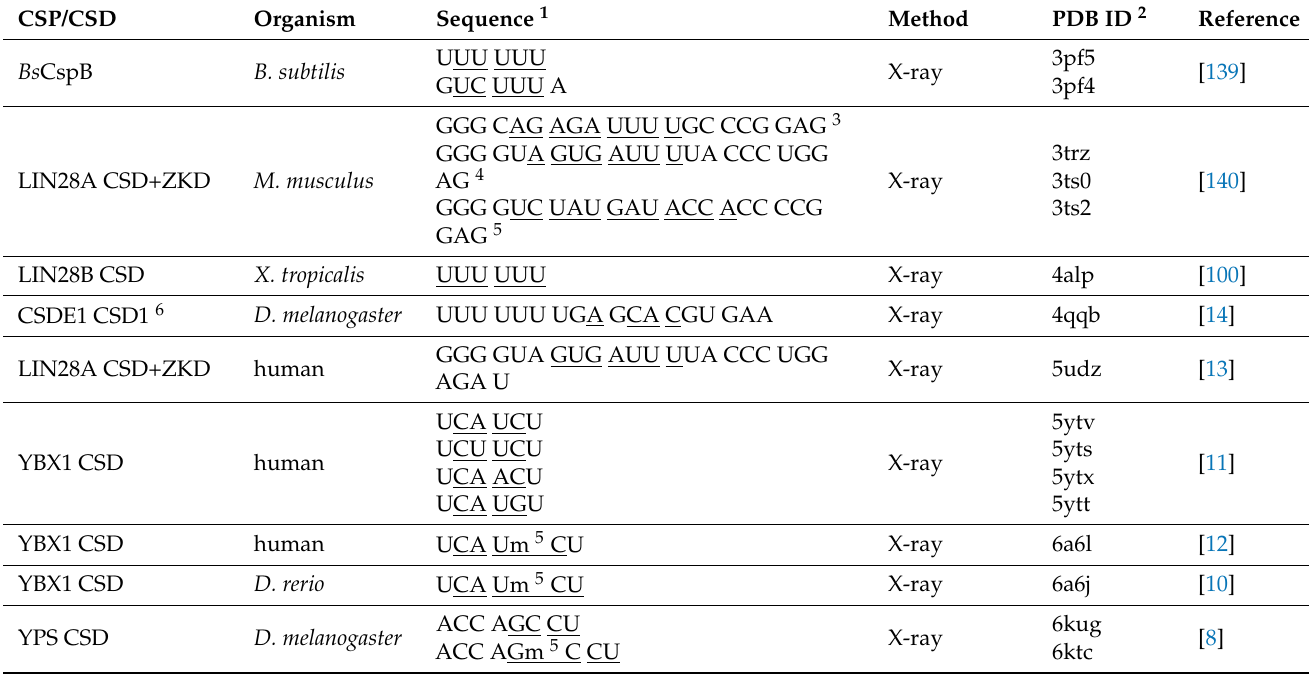
Table 2. Structures of CSP/CSD: RNA complexes.